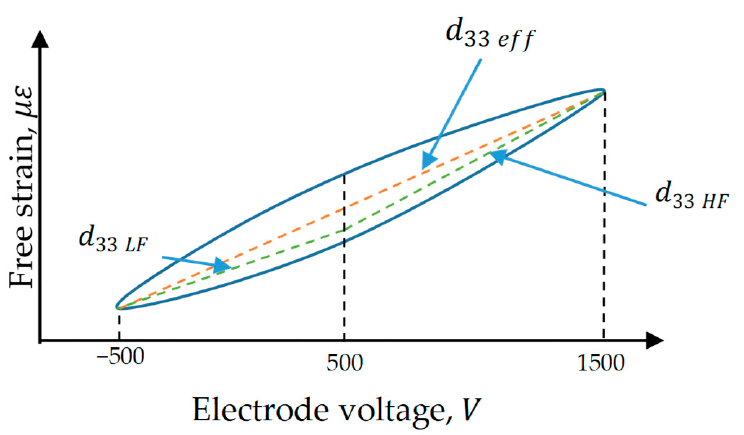
Figure 1. Longitudinal free strain versus applied electrode voltage showing the piezoelectric constant variation with the voltage range.